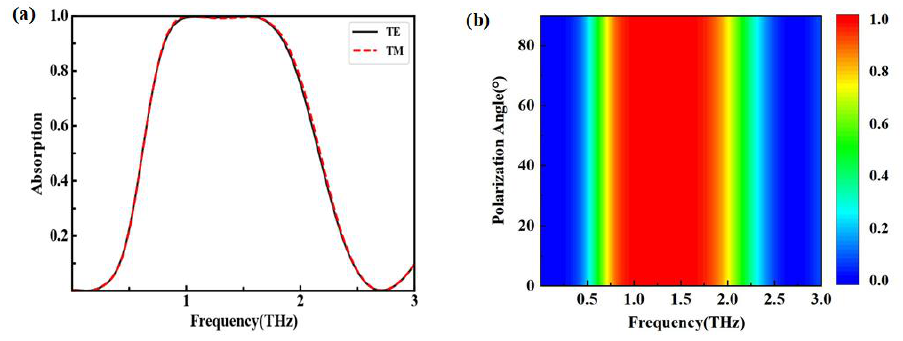
Figure 8. Absorption properties with different µ c . ( a ) Absorption spectra; ( b ) absorption contour view.